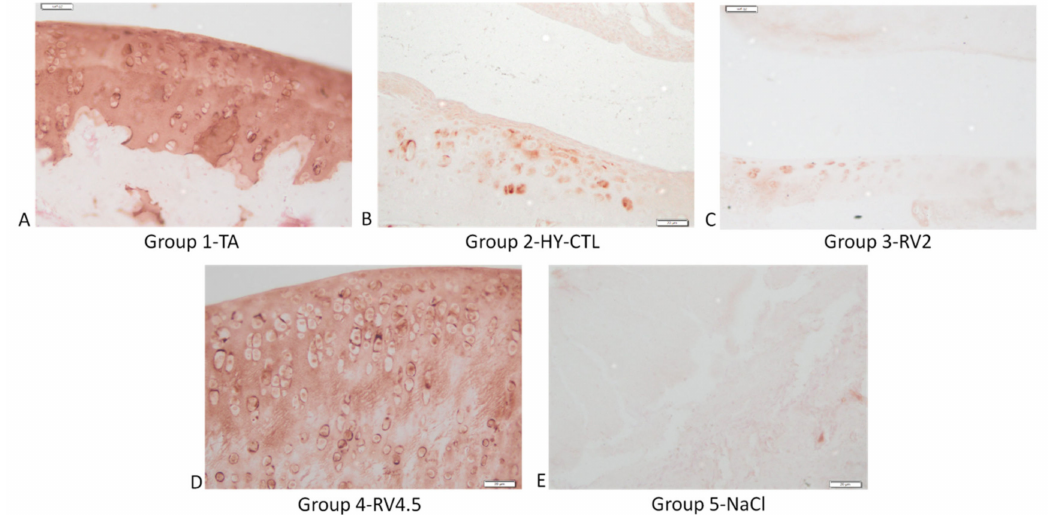
Figure 8. Immunohistochemical assessments of the right knee joints of rats. Images of the medial aspect of the joints treated with i.a injection of TA ( A ), HY-CTL ( B ), RV2 ( C ), RV4.5 ( D ) and NaCl ( E ). Aggrecan staining, magnification 40 × , bar = 20 µ